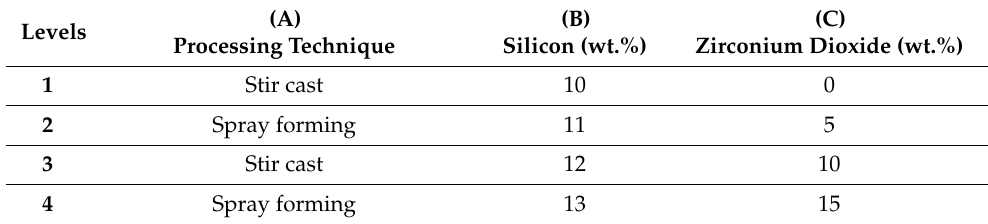
Table 2. Selected levels and